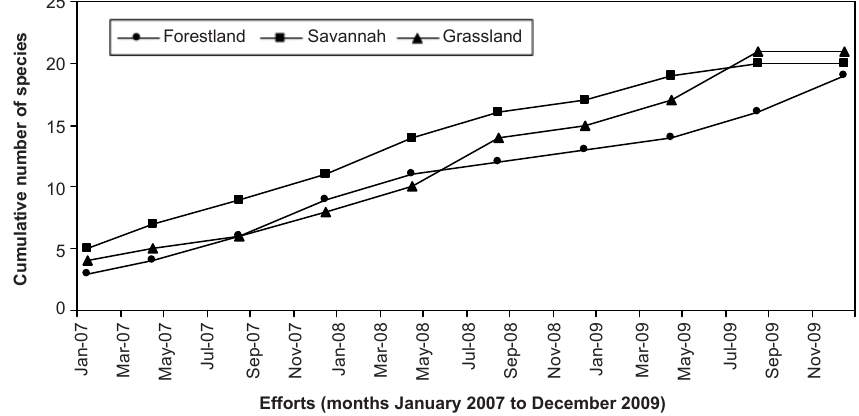
Figure 4. Species accumulation curve of orthopteroids in Kaziranga National Park,